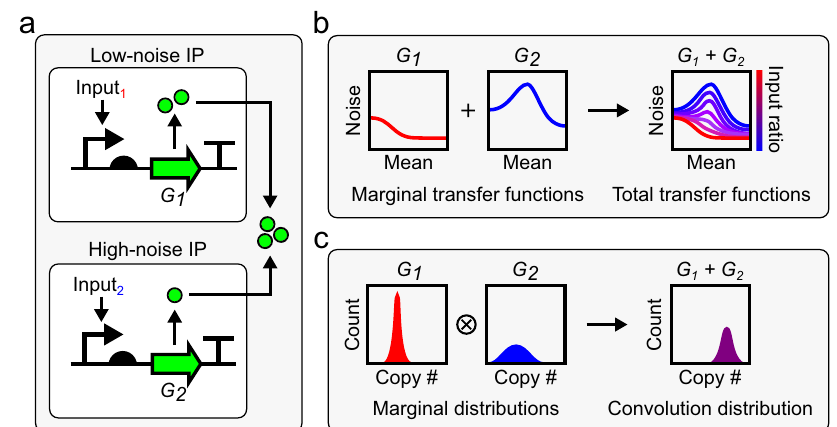
Fig. 1 Summation of gene expression from low and high noise IPs. a Two copies ( G 1 and G 2 ) of the same gene are expressed from two independently regulated IPs: one that produces low noise distributions and one that produces high noise distributions. G and G 2 , separately, are functions of their respective IP ’ s inputs (marginal transfer functions) and have single mean-noise trajectories. Mean and noise of the sum of G and G is a function of the amount and ratio of both IP ’ s inputs (total transfer functions) and can be tuned within the area de fi ned by their 1 2 marginal transfer functions. c When G 1 and G 2 are summed, their marginal distributions form a convolution ( (cid:3) ).